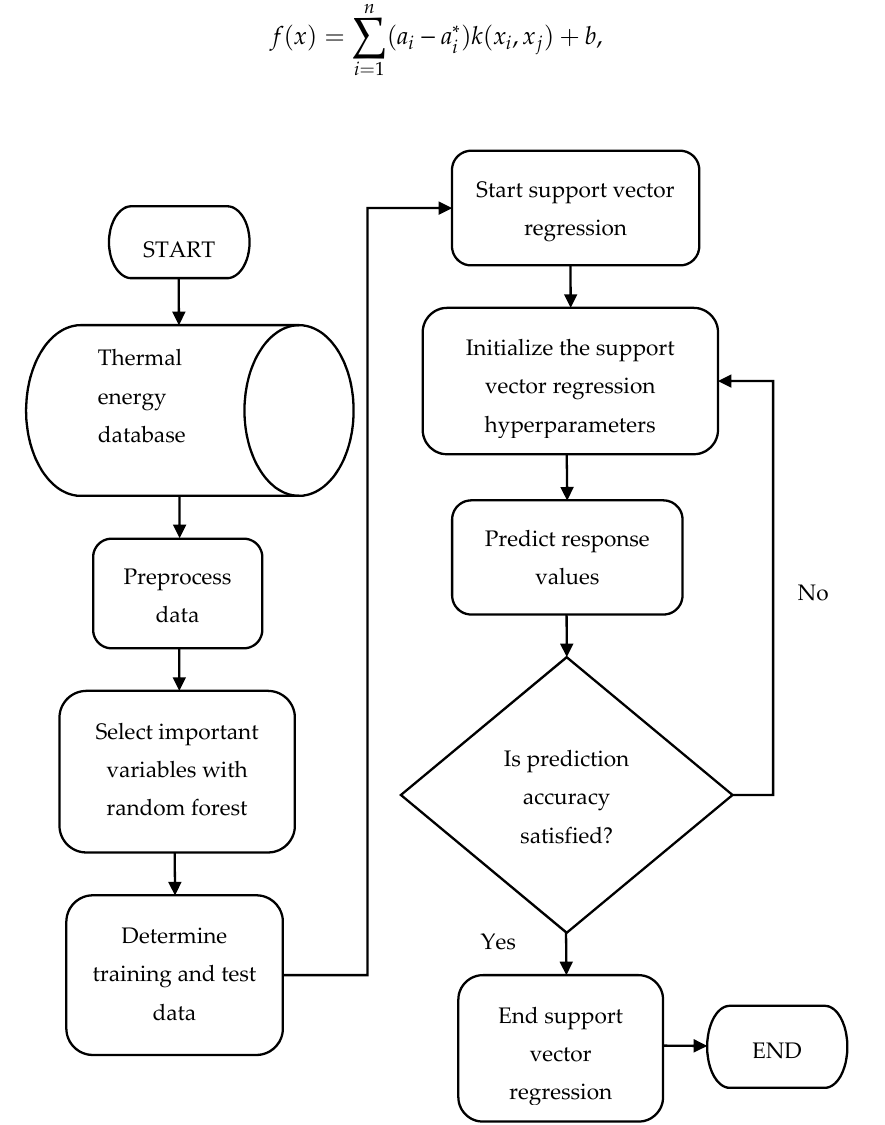
Figure 9. Flowchart of support vector regression model.